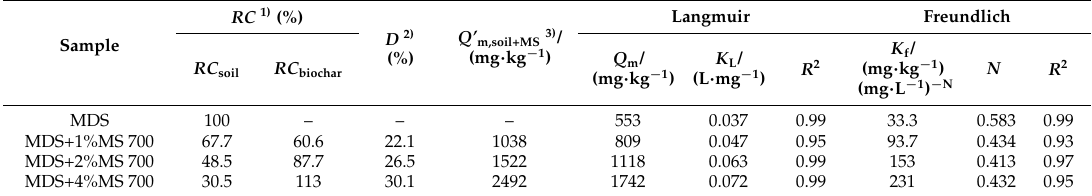
Table 5. Regression parameters of Langmuir and Freundlich model fittings for Cd adsorption isotherms and calculated values on the MDS amended with different weight ratio of MS700.